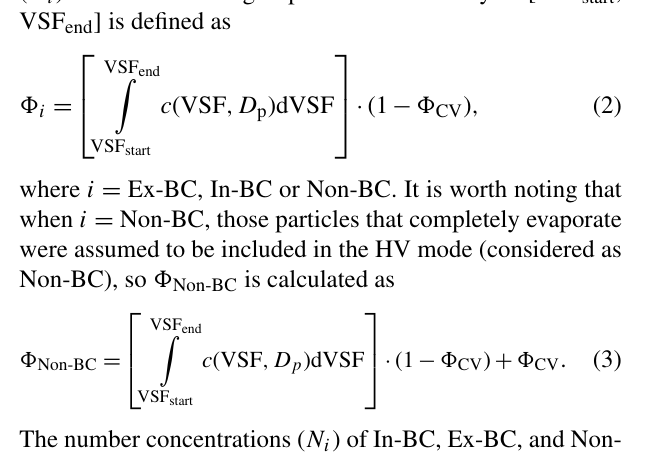
Figure 2. Particle number size distribution (PNSD) of ambient aerosols (in black), DMA 1 -selected particles with D p equal to 150nm (in blue), residual particles after heating at 300 ◦ (in red), and the fitting